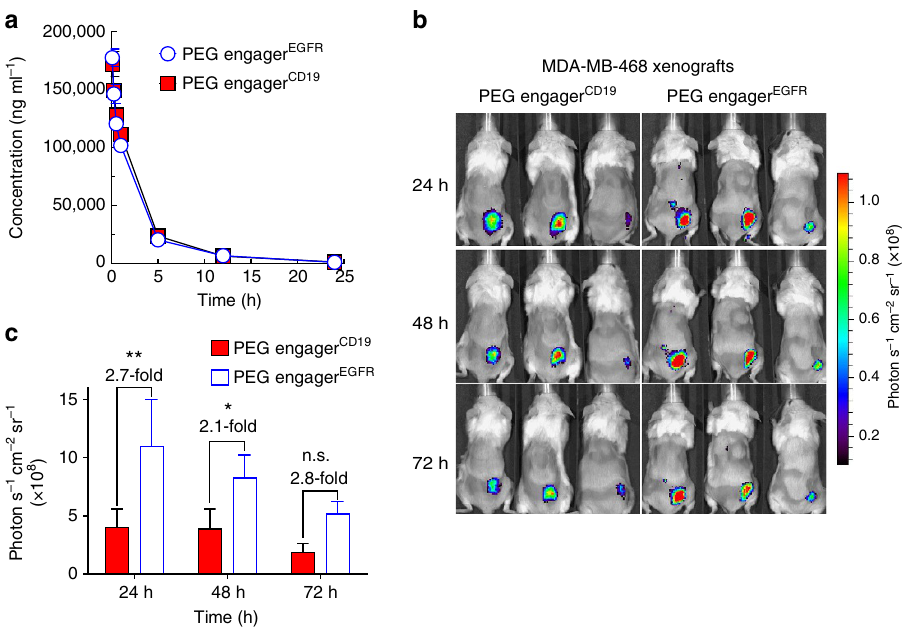
Figure 6 | Pharmacokinetics and imaging of PEG engagers in mice. ( a ) NSG mice were intravenously injected with 6mgkg (cid:3) 1 PEG engager EGFR (white circles) or PEG engager CD19 (red squares). Mean plasma concentrations of the PEG engagers were measured by sandwich ELISA ( n ¼ 3 mice). ( b ) Five hours before intravenous administration of 4armPEG 10k -NIR-797 probe (5mgkg (cid:3) 1 ), NSG mice bearing subcutaneous MDA-MB-468 tumours were intravenously injected with 6mgkg (cid:3) 1 PEG engager EGFR or PEG engager CD19 and the whole-body imaging were sequentially imaged at 24, 48 and 72h with an IVIS Spectrum imaging system. ( c ) The uptake of PEG-NIR797 in MDA-MB-468 tumours was determined by measuring fluorescence intensities ( n ¼ 3). Data are shown as mean ± s.d. Significant differences in mean fluorescent intensity between PEG engager EGFR and PEG engager CD19 groups are indicated: * P r 0.01, ** P r 0.001 (two-way analysis of variance). NS, not